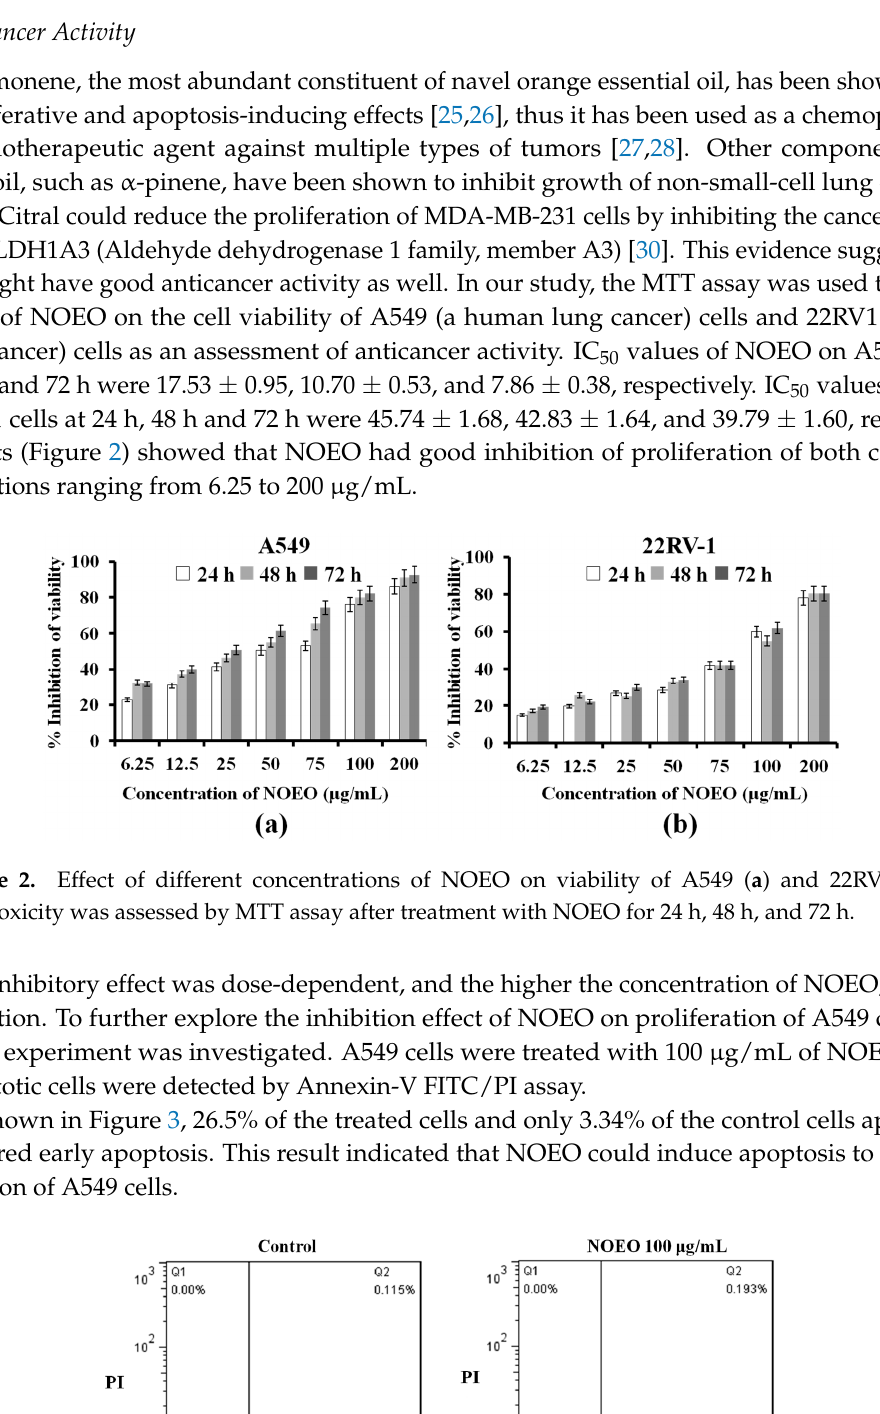
Figure 3. The apoptosis of A549 cells was induced by NOEO. Flow cytometric analysis of Annexin V-FITC/PI-stained A549 cells: ( a ) Cells not treated with NOEO as a control; ( b ) Cells treated with